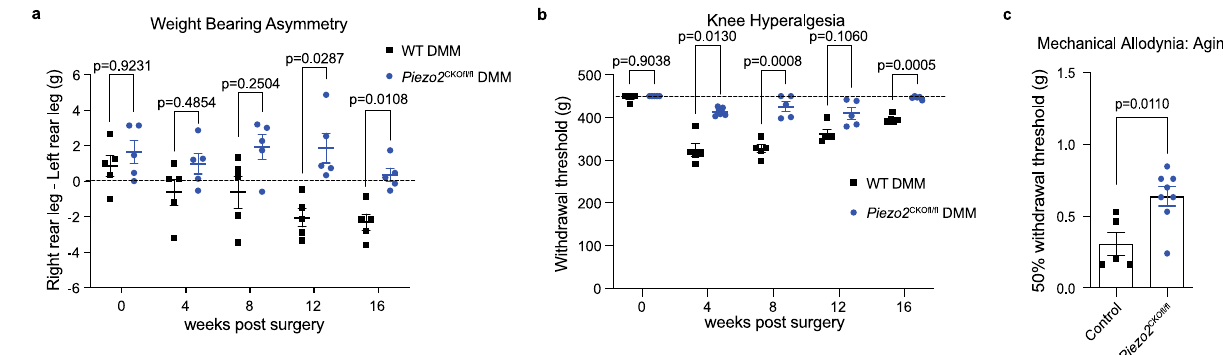
Fig. 4 | Piezo2 plays a role in mechanical sensitization in two mouse models of osteoarthritis. a Weight-bearing asymmetrywasassessed inwild-type(WT)( n =5; black squares) and Piezo2 CKOfl/fl ( n =5; blue circles) male mice after DMM surgery. Dashedlineindicates0gwhichwouldrepresentmiceputtingequalweightonboth hind legs; negative numbers indicate mice are putting more weight on the unin- jured left rear leg. Two-way repeated measures ANOVA with Sidak post-test. Mean±SEM. DMM destabilization of medial meniscus. b Knee hyperalgesia was assessed in mice from part a . Dashed line indicates maximum of the assay: 450g. Ipsilateral operated right leg data is plotted. Contralateral unoperated left